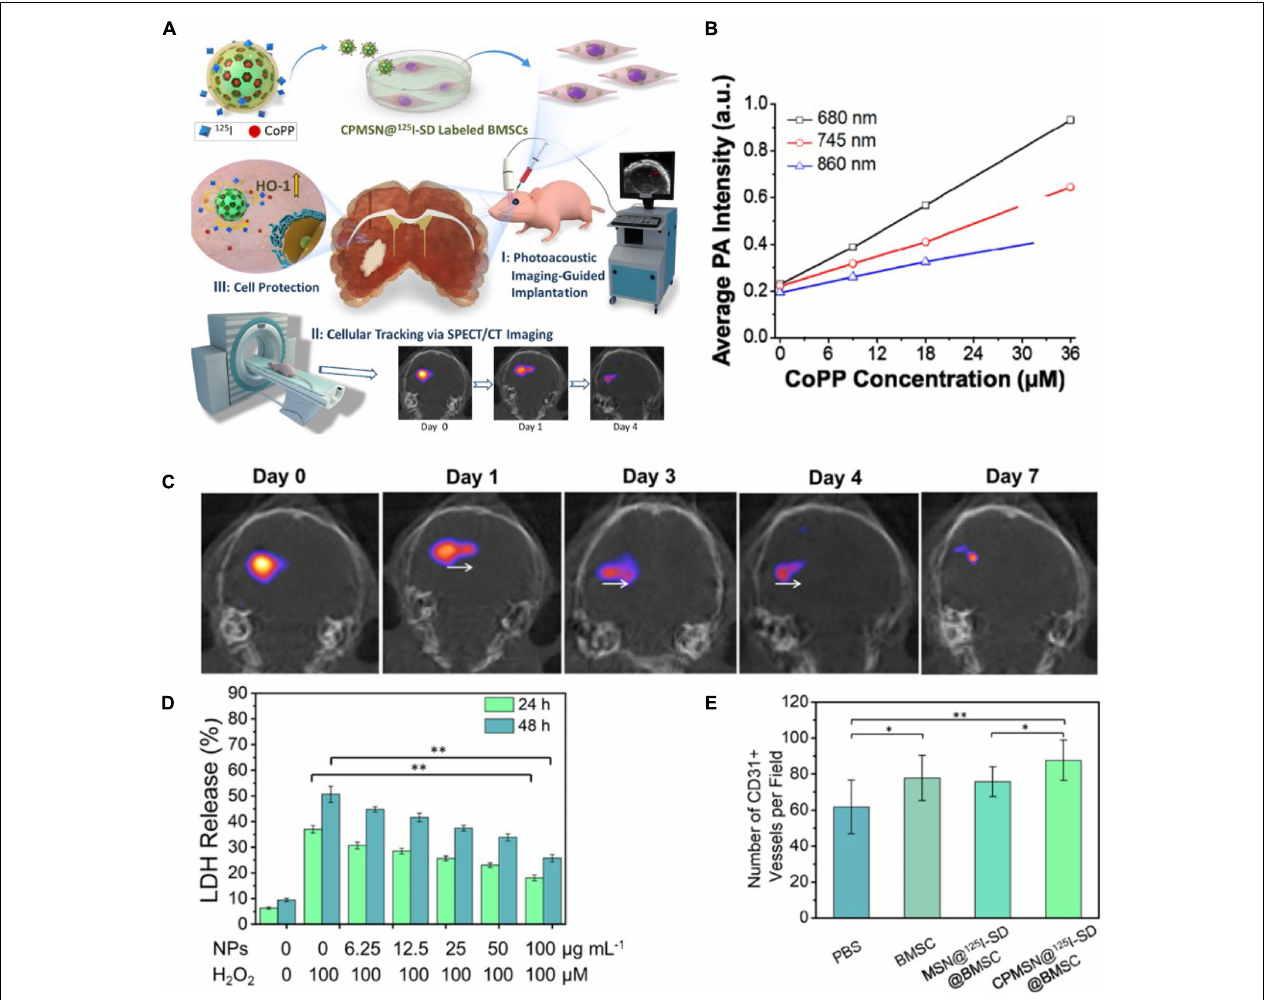
FIGURE 6 | (A) Schematic illustrating the triple functionality of CPMSN@125I-SD for stem cell therapy of brain ischemia. (B) Corresponding average intensities of CPMSN@125I-SD with various cobalt protoporphyrin IX (CoPP) concentrations in the NIR region. (C) Single-photon emission computed tomography imaging (SPECT)/CT images of ischemic mouse brain tissue on different days (0–7 days) after intracerebral injection of the labeled BMSCs (500,000 cells). (D) Cell death assessment for MSCs after treatment with different concentrations of CPMSN@125I-SD (0–100 µ g ml − 1 ) and exposure to 100 µ M H 2 O 2 for 24 and 48 h. (E) Bar graph showing the quantification of the number of CD 31 + cells (adapted from Yao et al., 2020). ∗ p < 0.05; ∗∗ p <